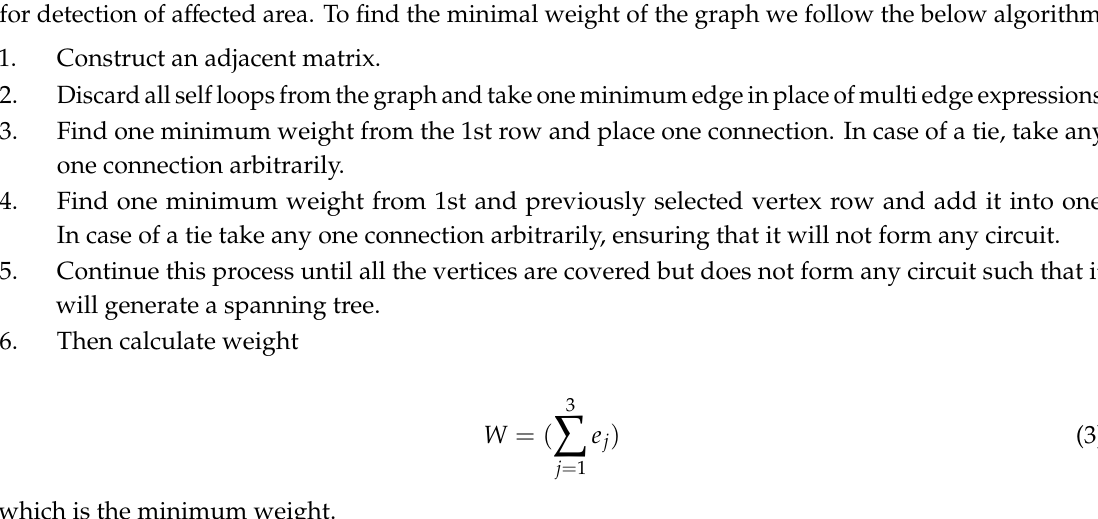
Figure 5. Example of a 4 × 4 sub matrix and its graphical representation .